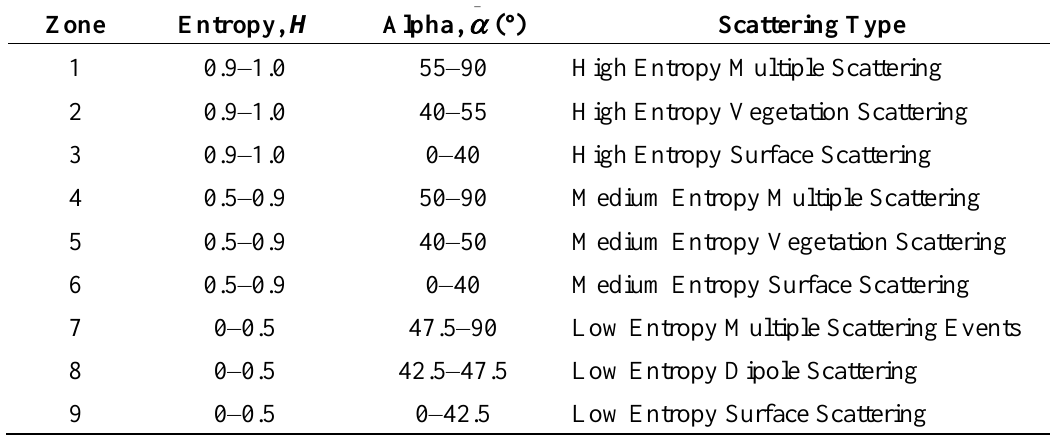
Table 2. The H-   Plane Partitioned into Nine Zones